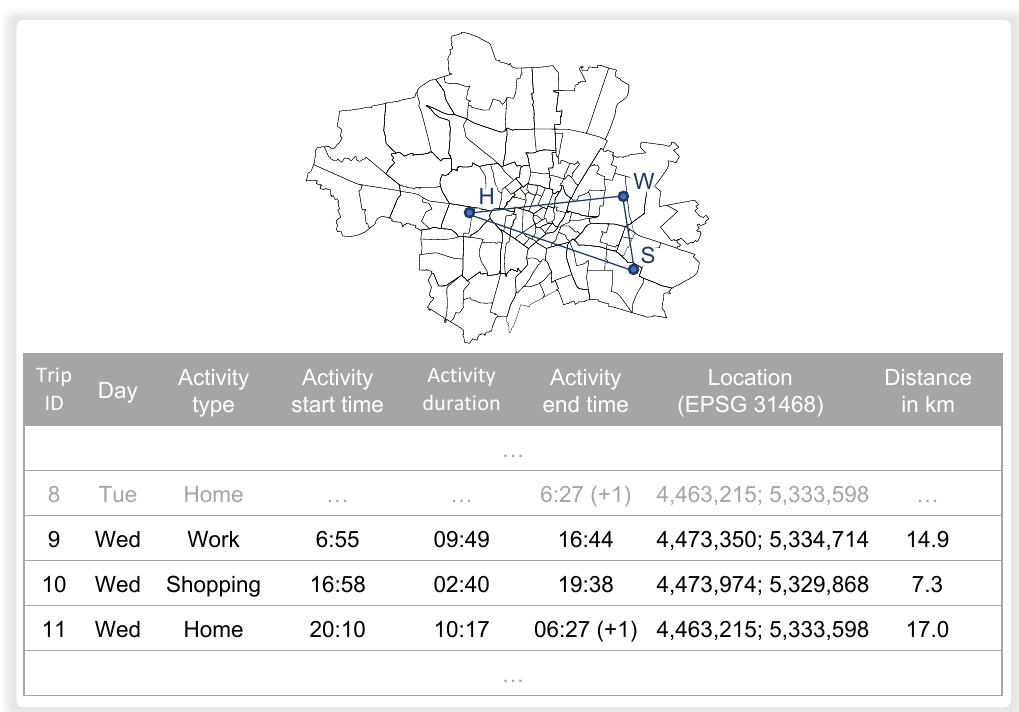
Figure 1. Exemplary mobility plan of all trips of an individual on one day. The last activity of the preceding day provides the work trip’s origin.